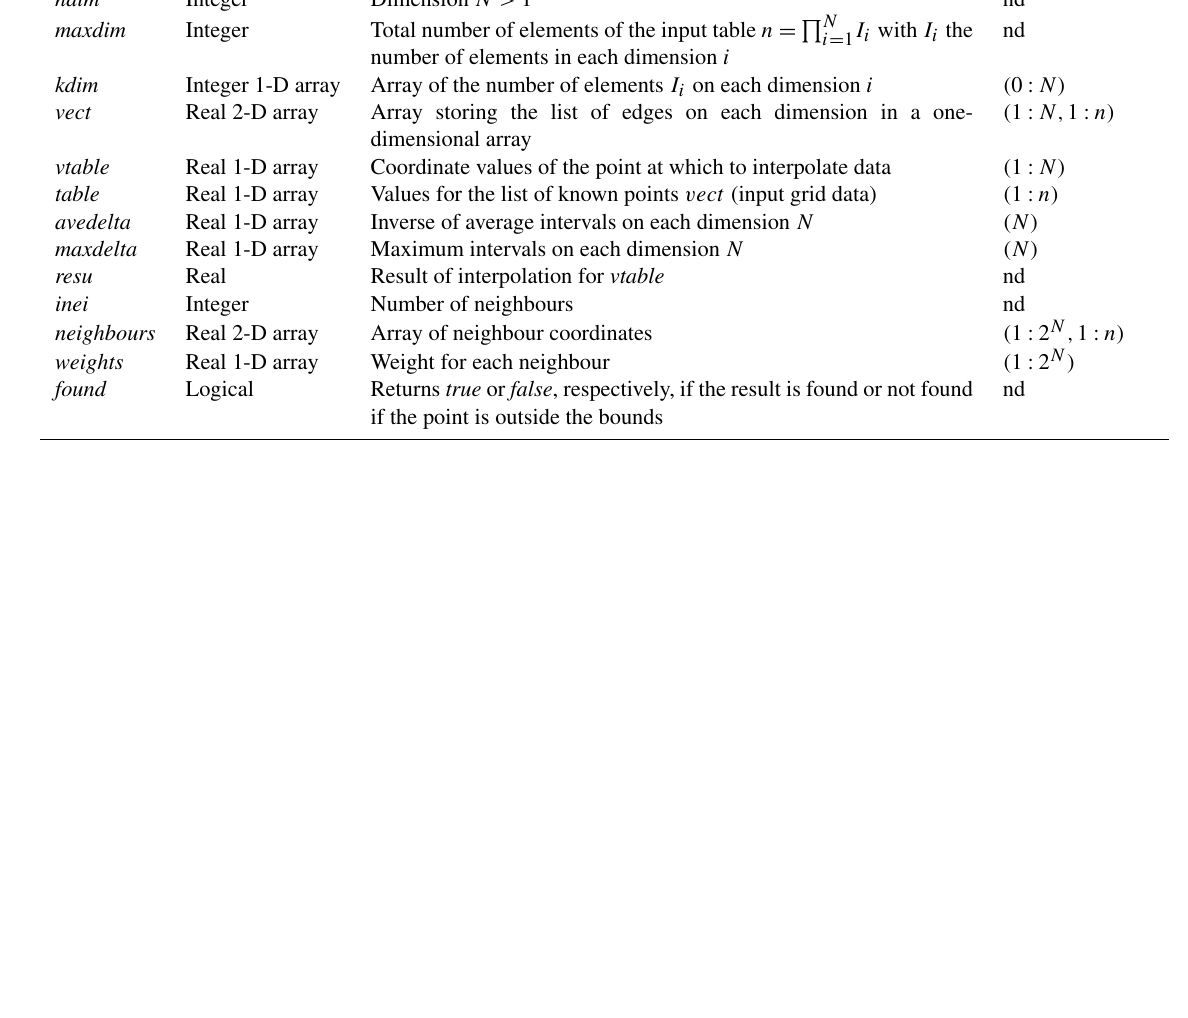
Coordinate values of the point at which to interpolate data table Real 1-D array Values for the list of known points vect (input grid